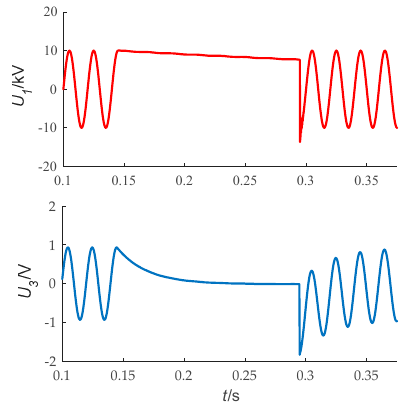
Figure 9. Waveforms of reclosing simulation.